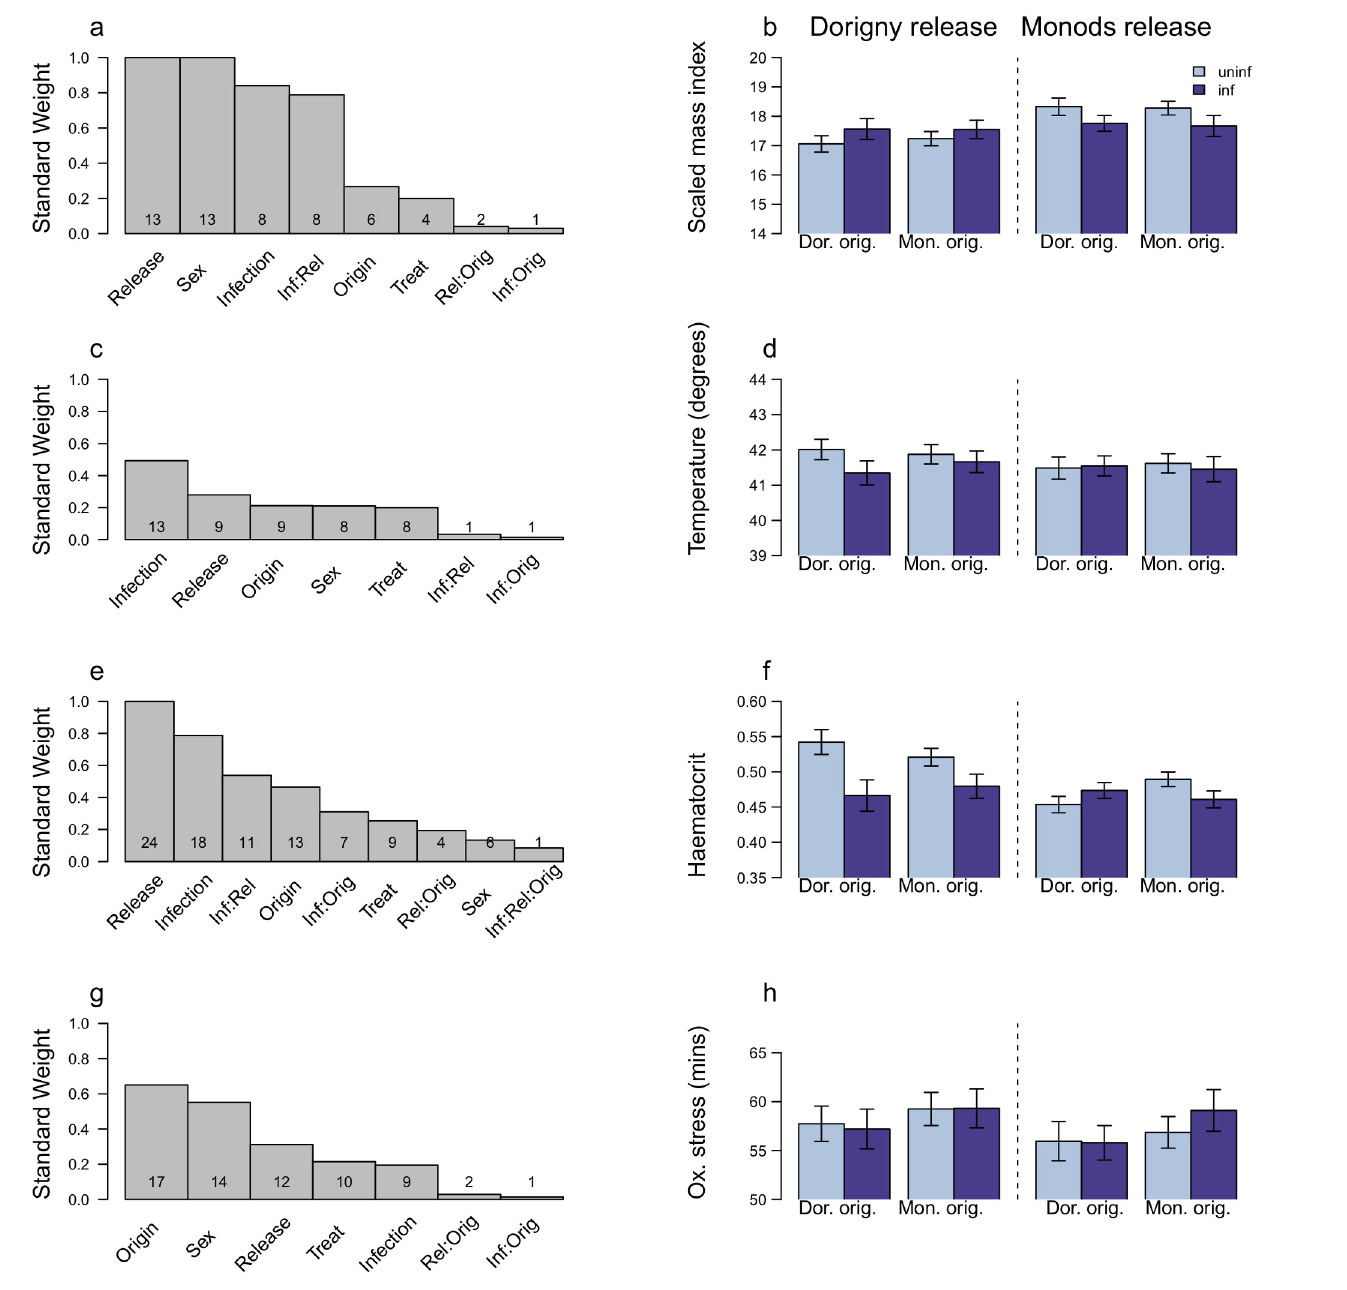
Fig 5. The factors that affect variables related to host pathology by the end of the experiment. a- b) SMI: standardised mass index; c- d) temperature; e- f) haematocrit; g- h) oxidative stress: membrane resistance (time taken to haemolyse half of red blood cells when faced with to free radical attack). The left hand panels (a, c, e, g) show the standard weight of the predictor variables affecting the host response variables and the number of candidate models in the 95% confidence interval model set that they occur. Note that the interaction term indicative of host LA (Infection x Origin x Release site) is not always present. In the right hand panels (b, d, f, h) the LA effect is explored (Infection x Origin x Release site) and in these models, the LA term is explicitly retained. The predicted model averaged parameter estimates ± 1 se of each response variable is plotted on the original scale. For full model formulae and results see tables in S1 File and S3 File. For further details of the method see Fig 1. The prediction, under a scenario of parasite adaptation, is that local birds will suffer more and have lower SMI, temperature (given previous studies have shown that infected birds can have a lower temperature), haematocrit and membrane